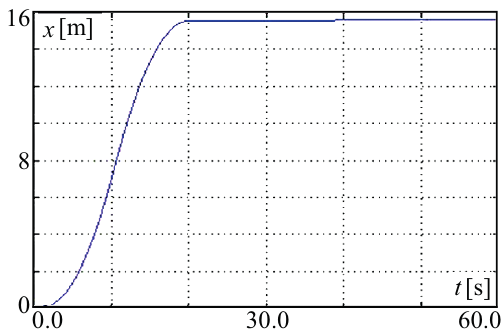
Fig. 14. Angle of rotation ψ( t ) about the OZ -axis